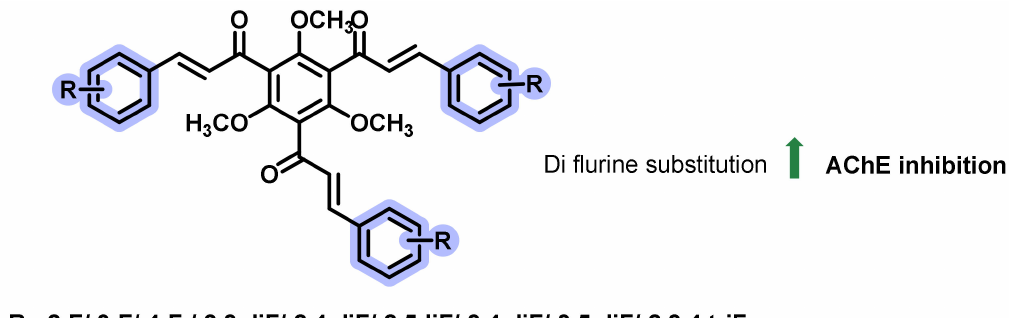
Figure 37. Fluorine-substituted tris-chalcone